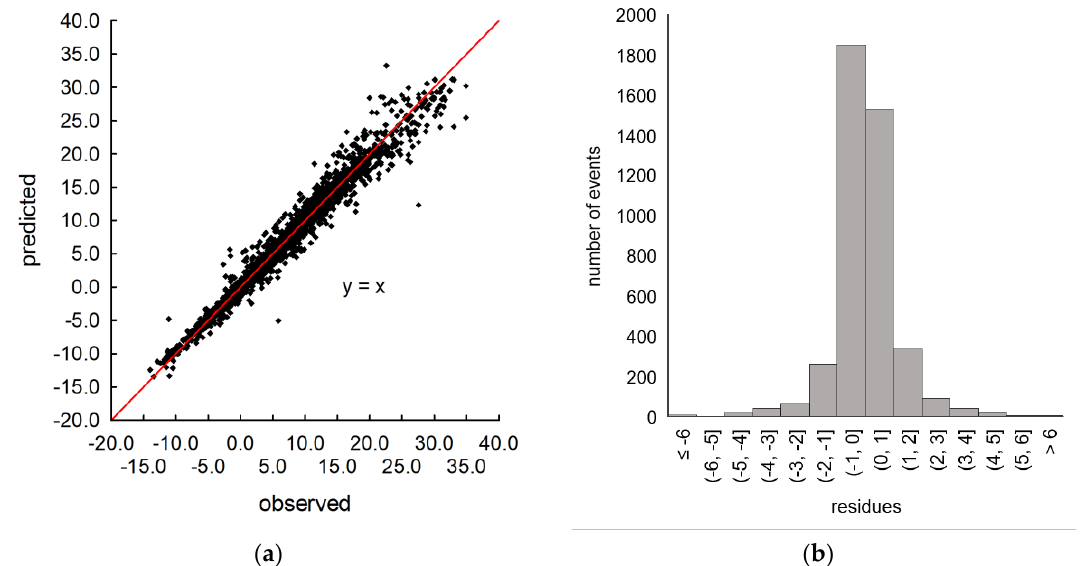
Figure 1. Scatter plot ( a ) and residual histogram ( b ) for MLP 3-3-1.